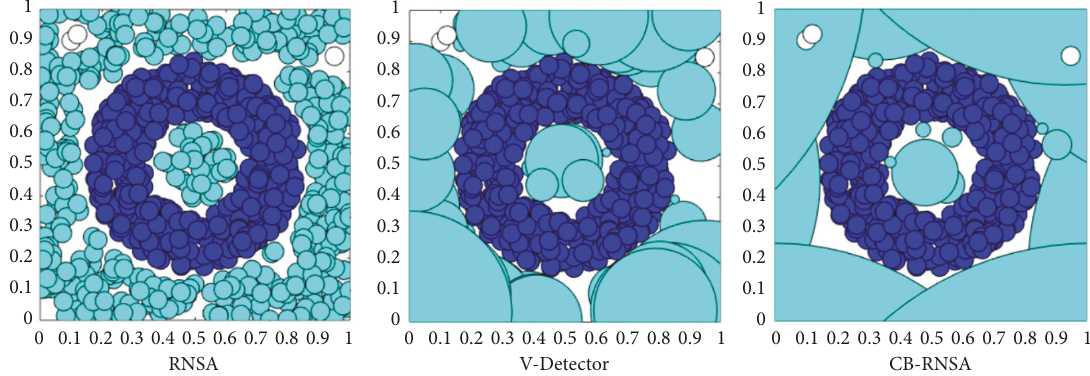
Figure 15: Comparisons of RNSA, V-Detector, and CB-RNSA in Ring (to achieve the expected coverage rate 90%, RNSA, V-Detector, and CB-RNSA need 477, 51, and 17 mature detectors, respectively, where the training set size is 500, the self radius is 0.03, and the detector radius of RNSA is